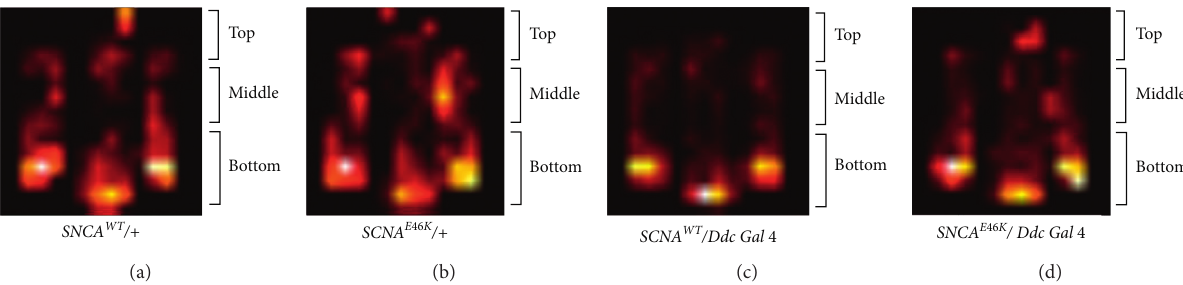
Figure 7: SNCA E46K transgenic flies move less and slower. An automated fly tracking using iFLY apparatus demonstrates the lower general movement of SNCA E46K /+ ; Ddc/+ when compared to the control genotype SNCA E46K /+ . The position of the control flies in the first 2,699 frames (a) is compared to the position of SNCA WT expressing flies (b). The heat map figure shows a decline in locomotor activity among the PD model transgenic flies. Position histogram of 2,699 frames captured from control genotype, SNCA E46K /+ (c), and that of SNCA E46K /+ ; Ddc/+ genotype (d) indicates control flies spent more of their time on the top of the tube but are able to move across the whole tube. While SNCA transgenic Drosophila flies prefer to stay at the tube bottom and do not climb up. Lighter heat map spots indicate stationary